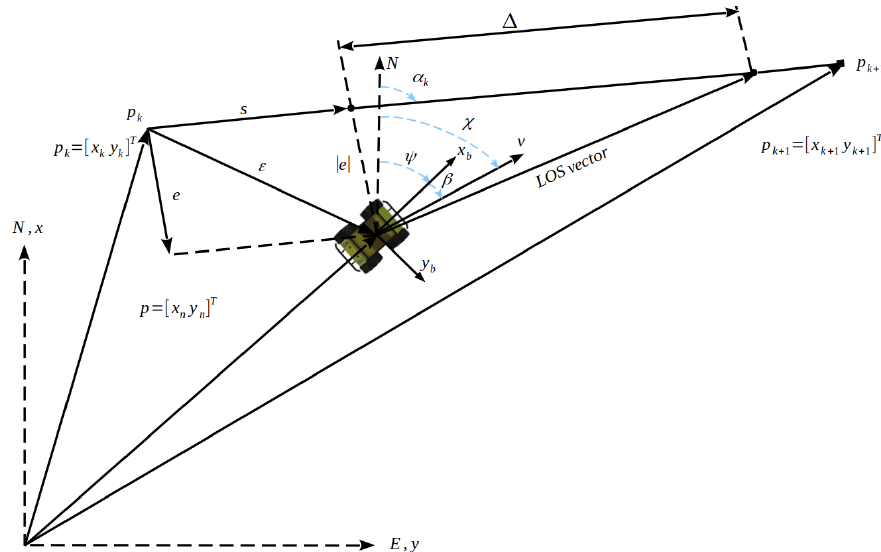
Figure 10. Line-of-sight path-following